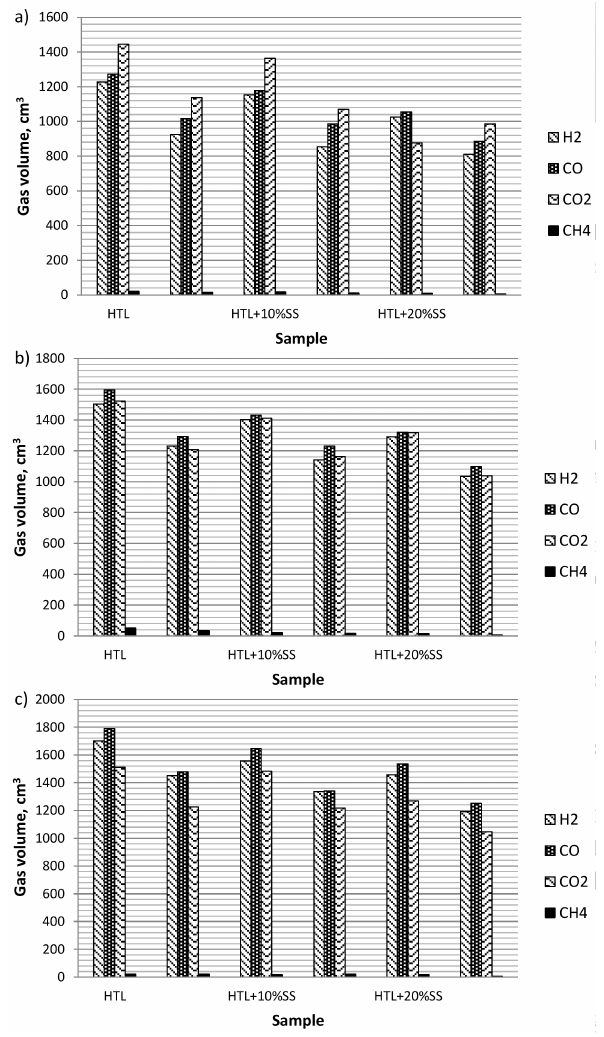
Figure 1. Volumes of the main gaseous components produced in steam co-gasification of Helianthus tuberosus L. or Miscanthus x giganteus biomass with sewage sludge at: ( a ) 700 ◦ C; ( b ) 800 ◦ C; and ( c ) 900 ◦